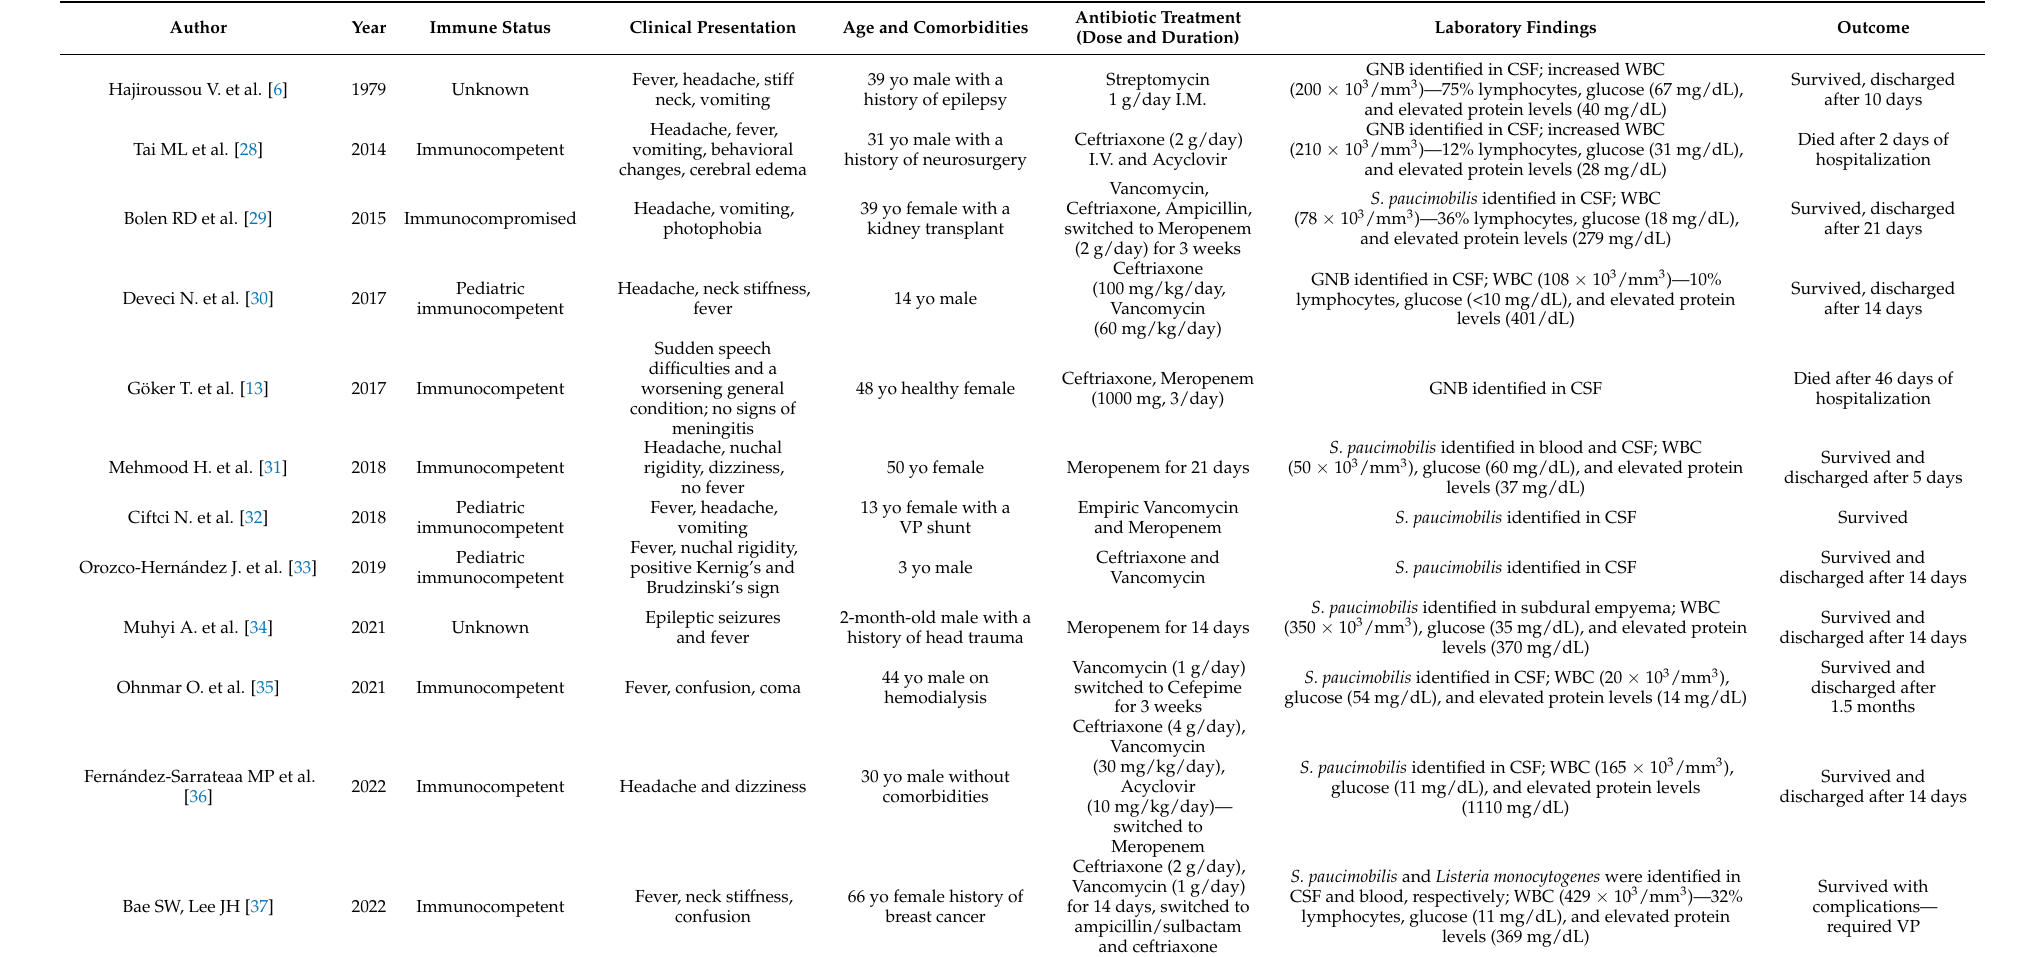
Table 3. Case reports of Sphingomonas paucimobilis